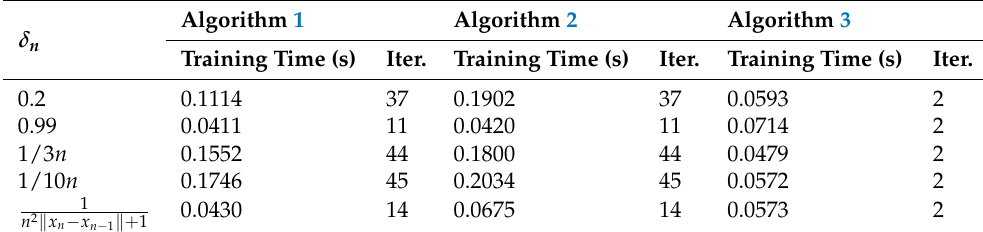
Table 3. Numerical results of different parameters δ n .